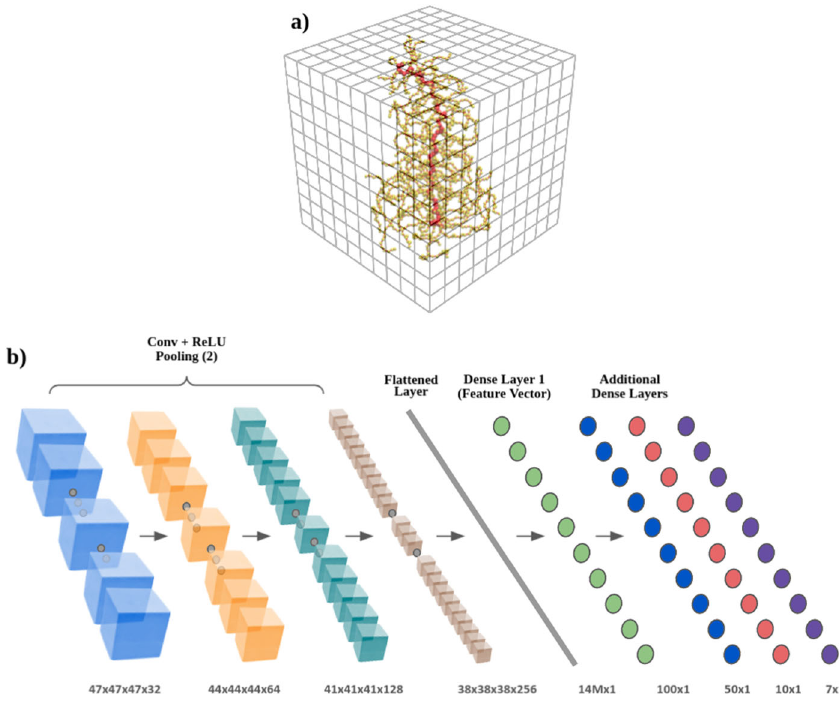
Fig. 4 CNN model development. a Schematic of the grid generation. b Architecture diagram for the developed CNN